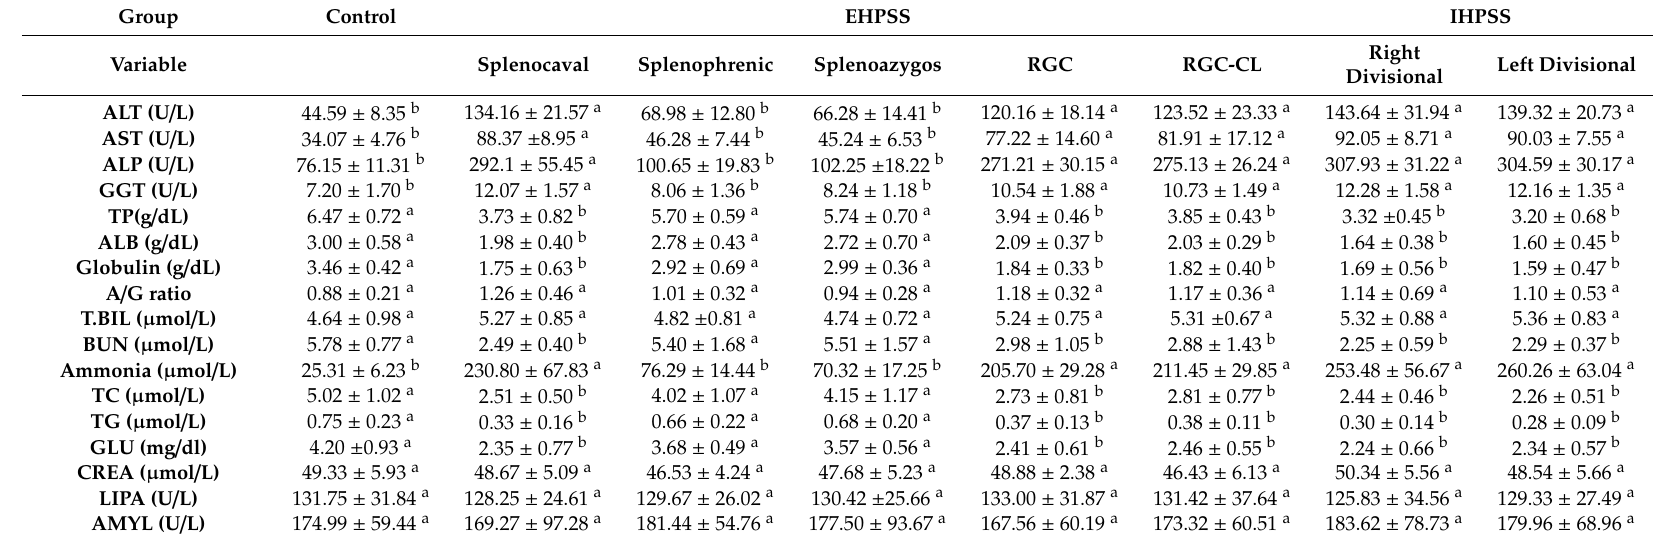
Table 3. Biochemical panel in dogs a ff ected either with extrahepatic or intrahepatic portosystemic shunts (EHPSS or IHPSS) as well as the healthy control ones.